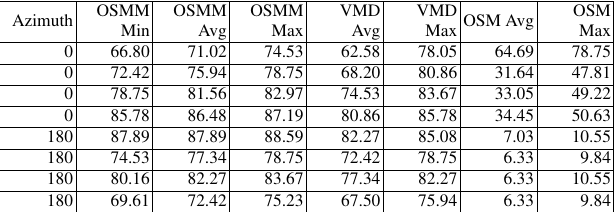
Table 5: Variation in Elevation Across the Three Data Sources North/South Across the Street - Clutched Friars